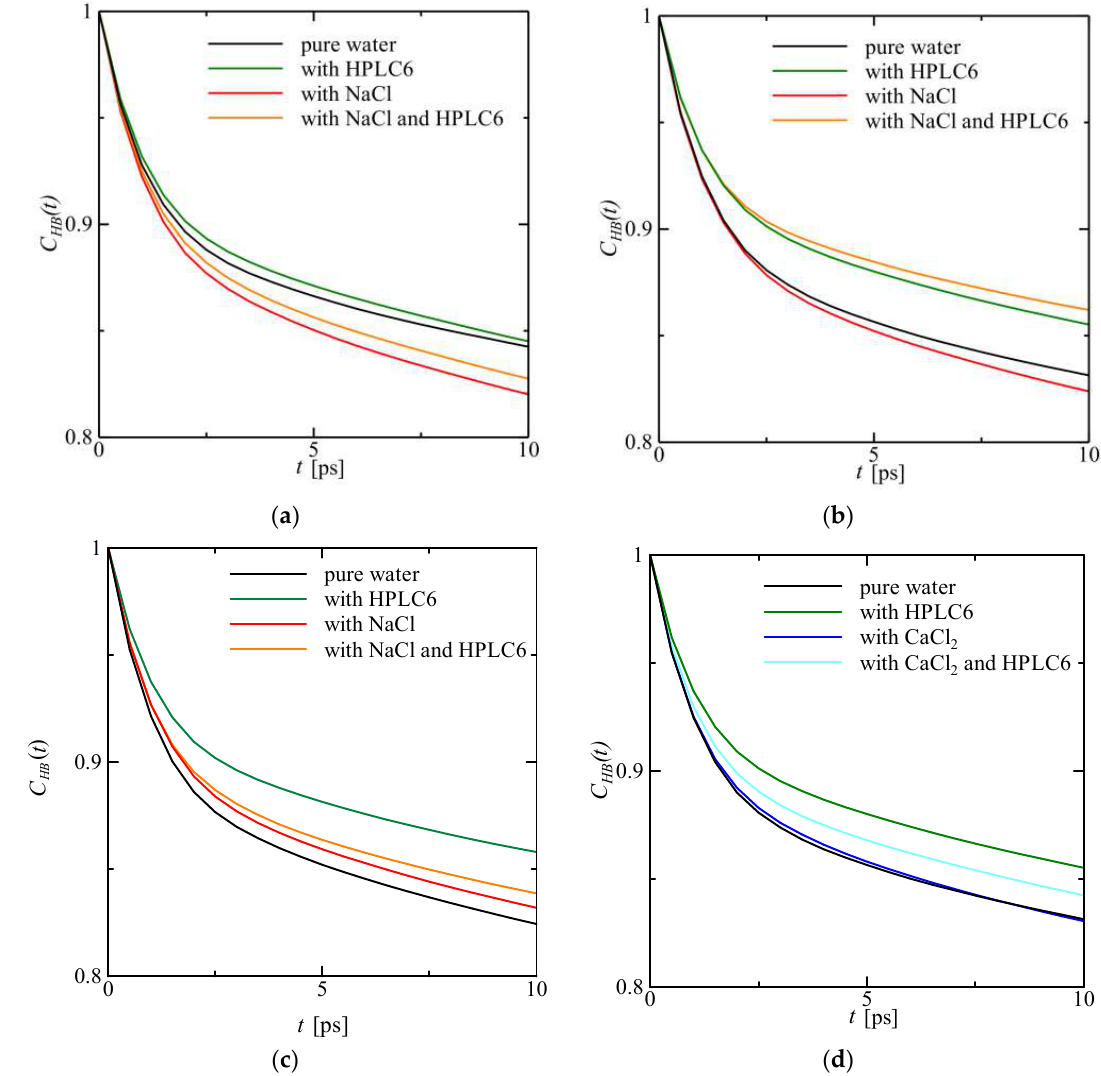
Figure 6. Hydrogen bond correlation functions in two layers; ( a ) 5th layer for 1000–1050 ps, ( b ) 8th layer for 1000–1050 ps, ( c ) 5th layer for 1950–2000 ps, ( d ) 8th layer for 1000–1050 ps.